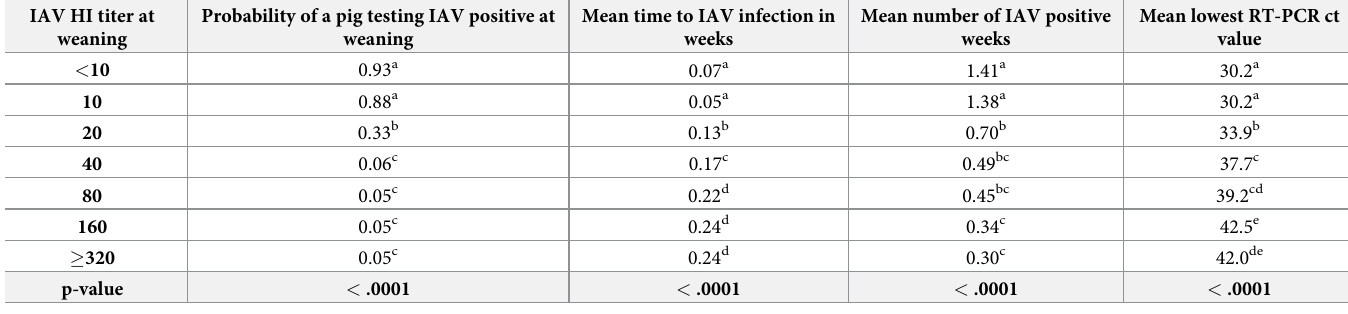
HI, Hemagglutination inhibition assay; IQR, Interquartile range; RT-PCR, Real-time reverse transcriptase polymerase chain reaction; ct, cycle threshold. Different superscripts in each column mean statistically significant differences after adjusted pairwise comparisons (p-value <